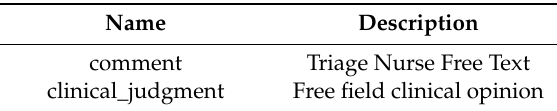
Table A1. Nominal free field variables.